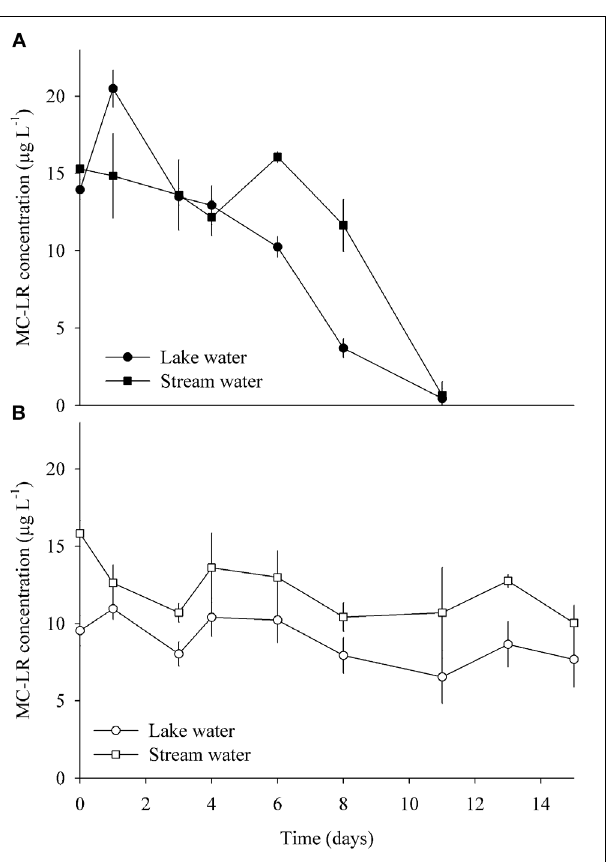
FIGURE 6 | MC degradation in enrichment cultures amended with pure MC, using water from the lake and stream, respectively, and incubated under (A) anaerobic and (B) aerobic conditions (means ± one standard deviation of three replicate